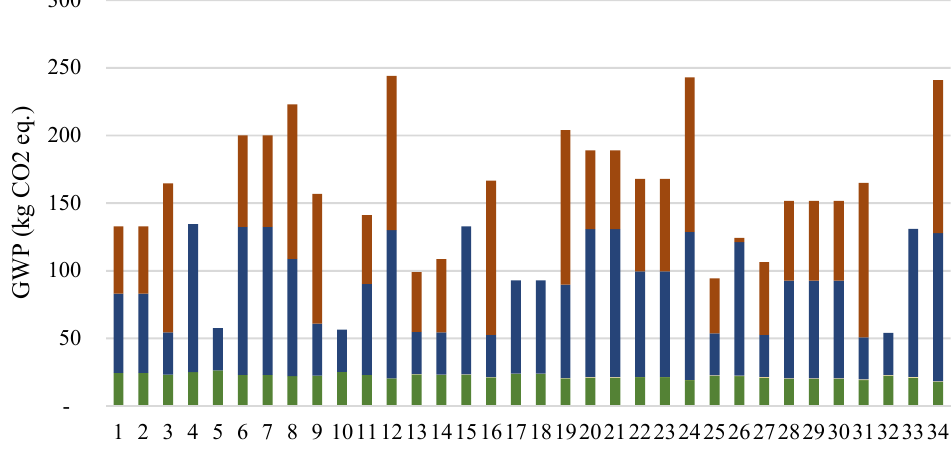
Figure 11. GWP of the analyzed mixes.